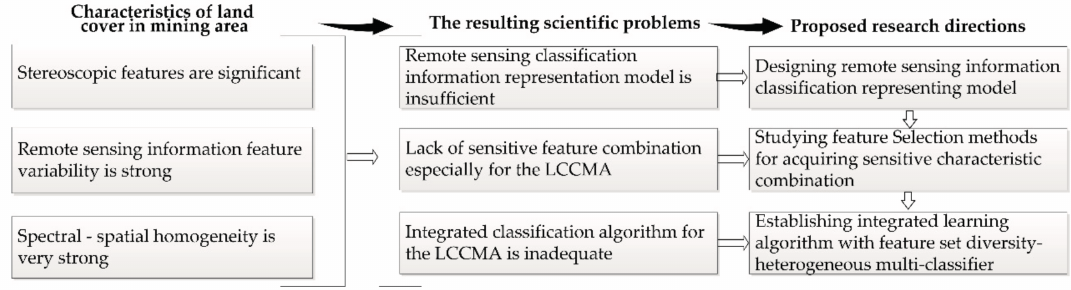
Figure 1. Scientific issues for the LCCMA and proposed research directions.